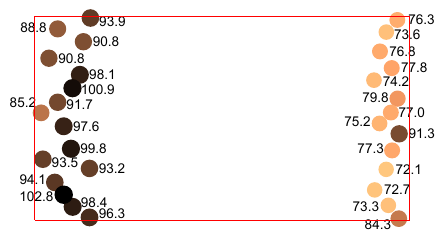
Figure 8. Optimal layout and relative power for dominant wind- direction case (angle of ± 7.5 ◦ ). Relative power results are obtained from large-eddy simulations. Turbine locations are marked with coloured disk: size and colour scale by relative power. Plot bound- ary (red box) corresponds to boundaries of domain (cid:127) (see Fig. 1). Table 7. Dominant wind-direction case – evaluation of optimal lay- out. Relative power for three different wind directions comparing outputs of LES and Jensen wake model with k w =